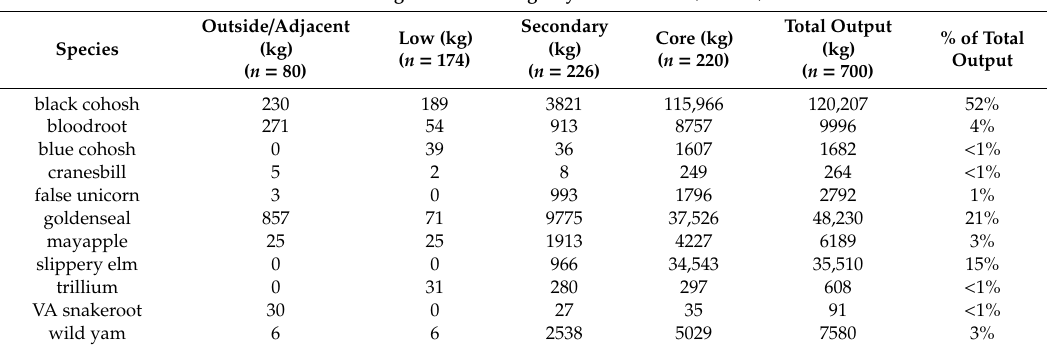
Table 8. Projected purchased volume in kilograms of eleven medicinal NTFPs for 15 states in the eastern US. The overall volume is reported, as well as volume values by respondent clusters determined using predictors of buying behavior.